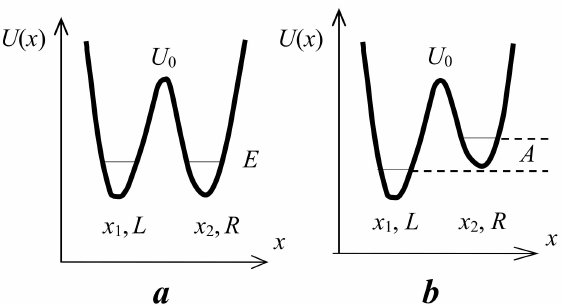
Figure 24. ( a , b ) Potential energy of the proton on the τ -bond of an isolated dimer (trimer, etc.) in the gas phase ( a ), the same energy of a real dimer in the crystal ( b ). E is the particle energy in the potential well, U 0 is the barrier height, ( x 1 , x 2 ) are the coordinates of potential energy minima. A is the difference between the energies of L - and R -tautomers in the crystal